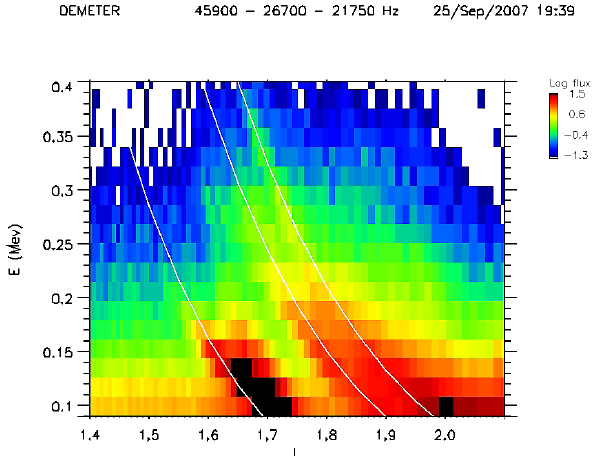
Fig. 10. Multiple electron wisps resulting from the cyclotron in- teraction of human VLF with electrons from the inner belt. Com- puted energy dispersions of electrons resonating with monochro- matic waves emitted at 45900, 26400 and 21750Hz are shown by the white